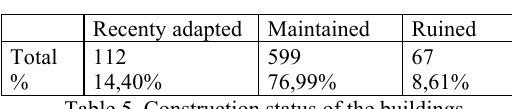
Table 5. Construction status of the buildings